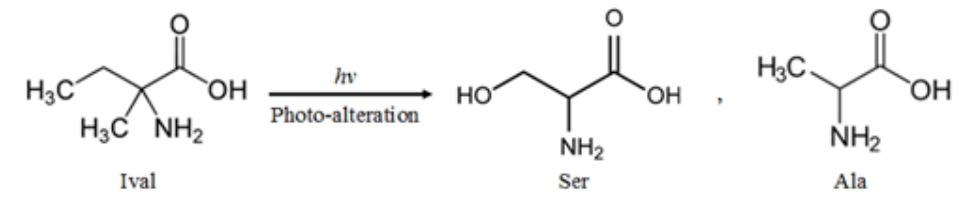
Figure 5. The photo-alteration process of Ival by the energetic photons forms dominantly Ser and